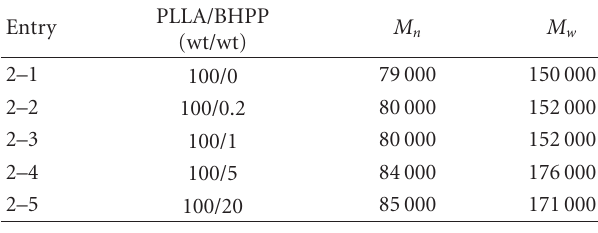
Table 2: Preparation of PLLA/BHPP blends with an extruder.